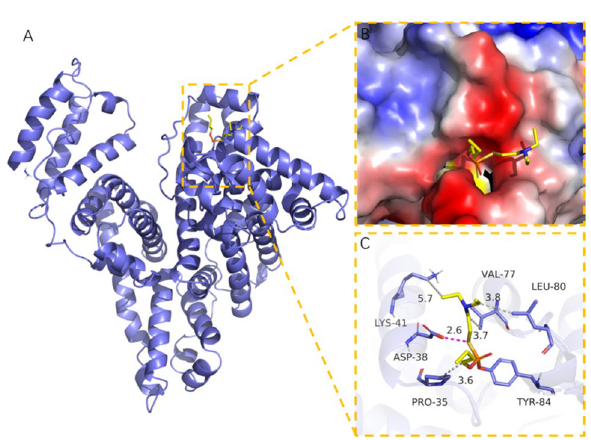
Figure 5. Detailed binding mode of Vs adducts in HSA. A was 3D structure of HSA, B showed VDM surface of binding site, C was interaction among Vs and active site residues. Residue number form